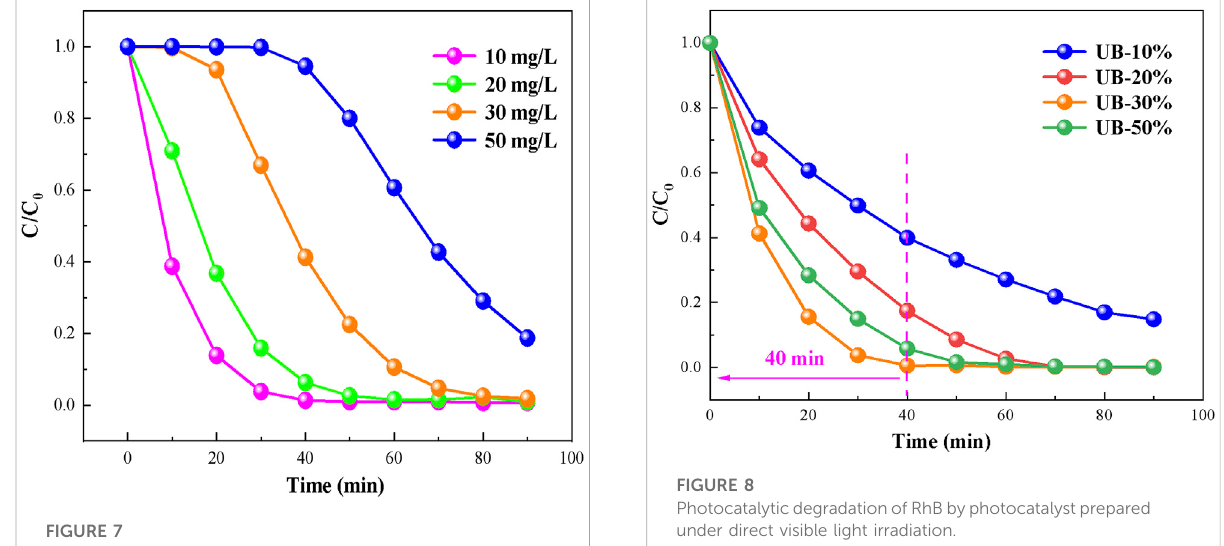
FIGURE 7 Degradation effect by UB-30% under different RhB concentrations.